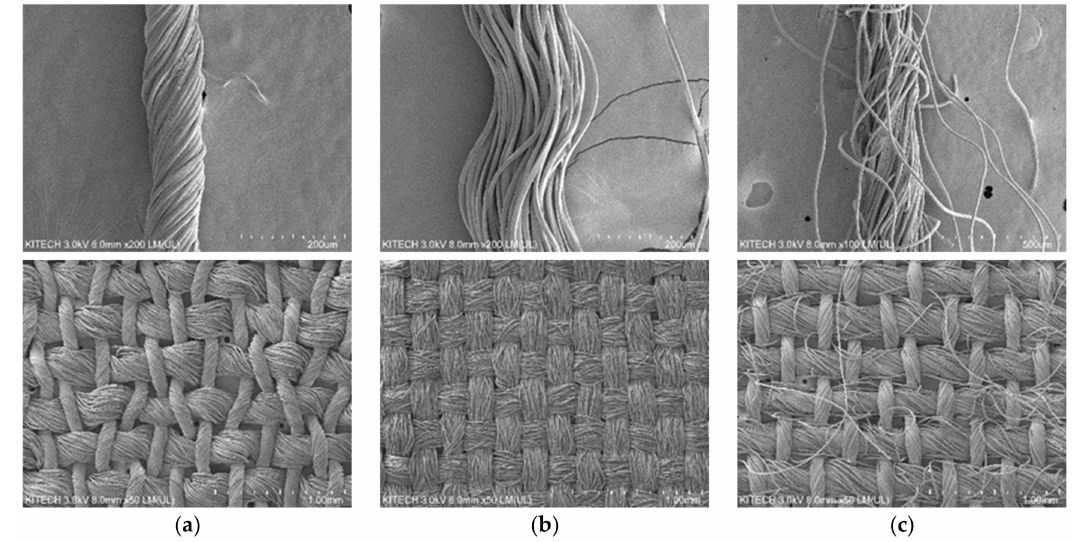
Figure 2. Scanning electron microscope images for identifying yarn type and fabric construction. ( a ) Plain woven with hard twist filament yarn; ( b ) Plain woven with non-twist filament yarn; ( c ) Plain woven with spun